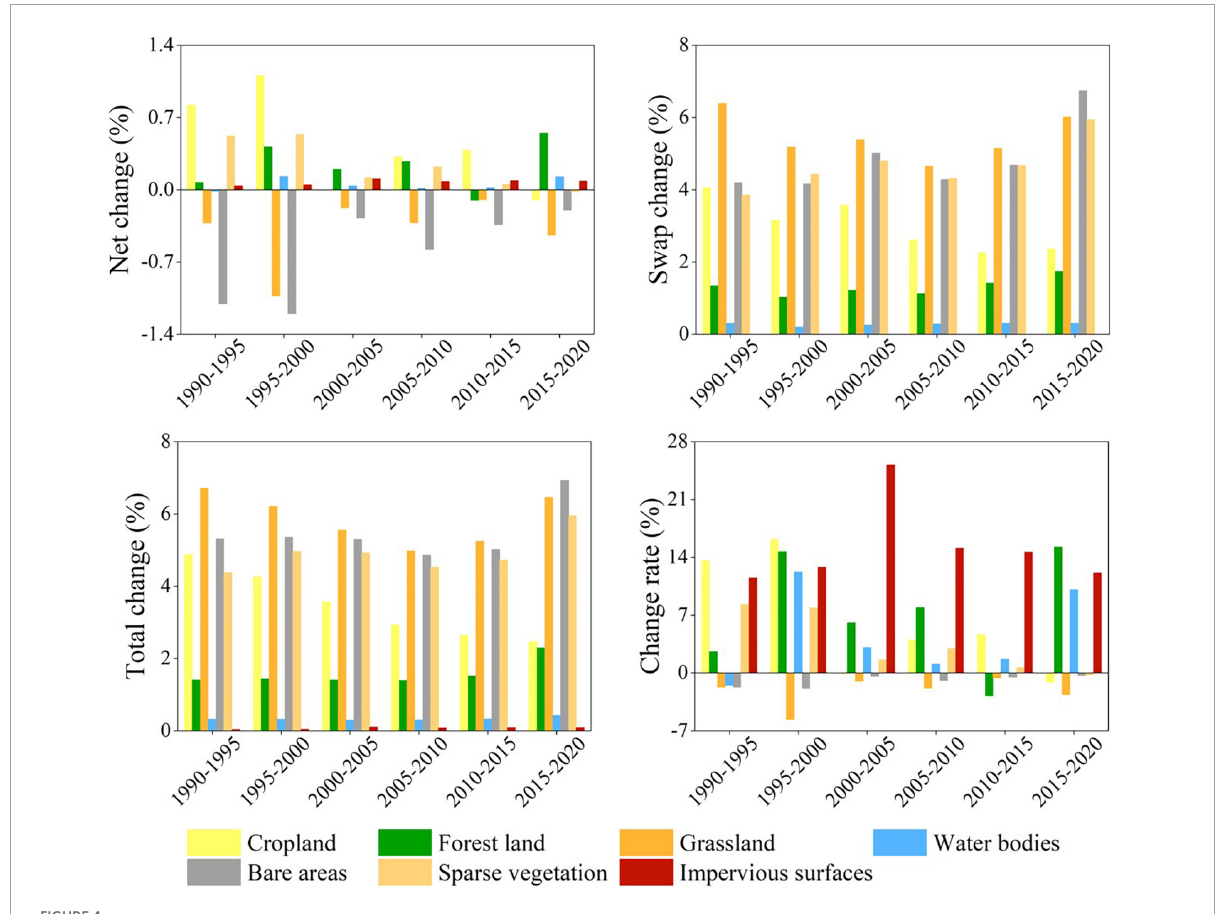
FIGURE4 The land use change indices at the category level of the NSTM during the 5-year